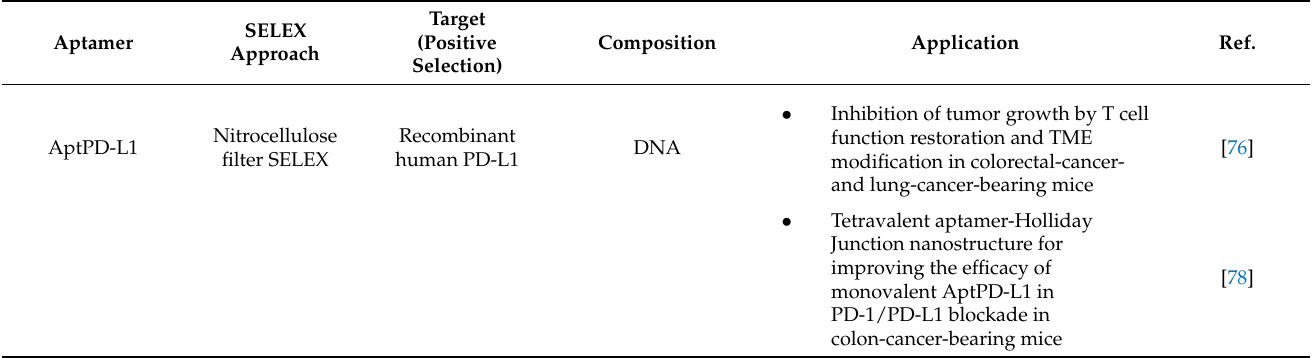
Table 2. Summary of anti-PD-L1 aptamers as cancer